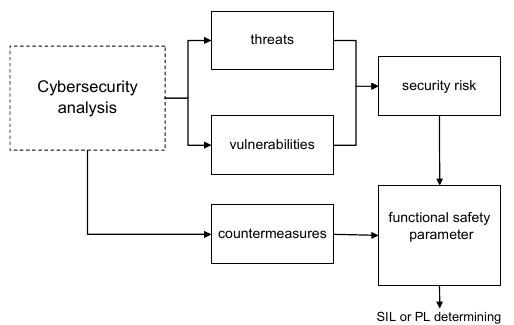
Figure 8. Procedure using cybersecurity factors in safety analysis [13].